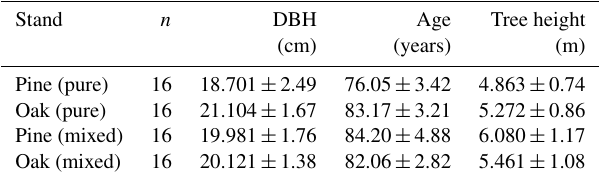
Table 2. Number of trees per stand and species included in the study of soil water potential ( n ), as well as mean or tree diameter at breast height (DBH), age estimated based on rings growth and total tree height of trees of Pinus cembroides and Quercus potosina at Sierra San Miguelito, San Luis Potosí,